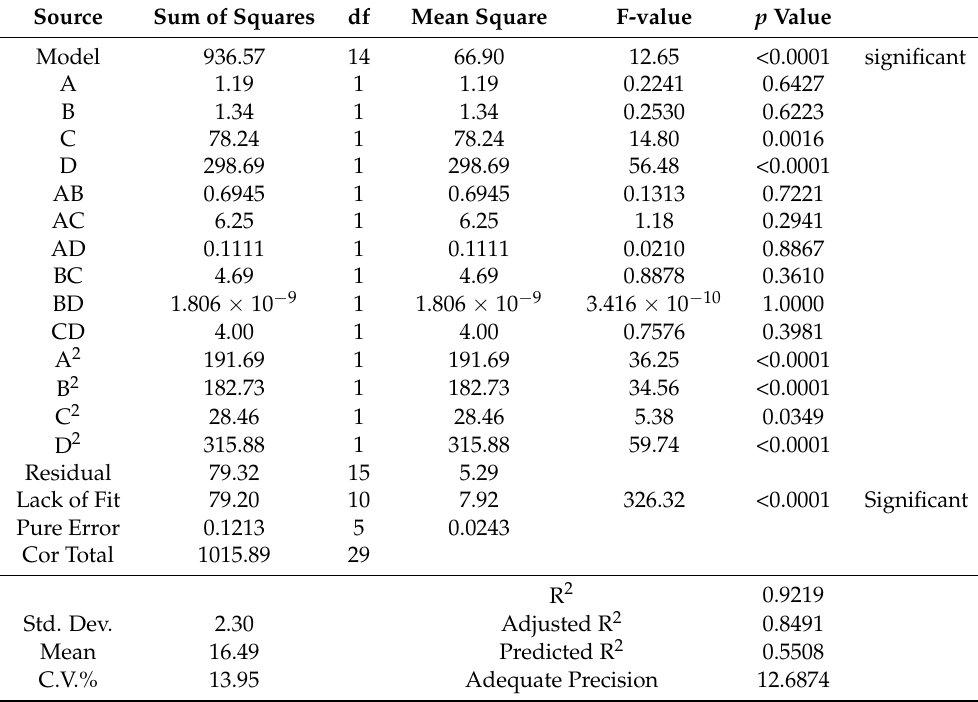
Table 6. Results of ANOVA for CCD model identifying factors and pairwise interactions significantly influencing diesel absorption.